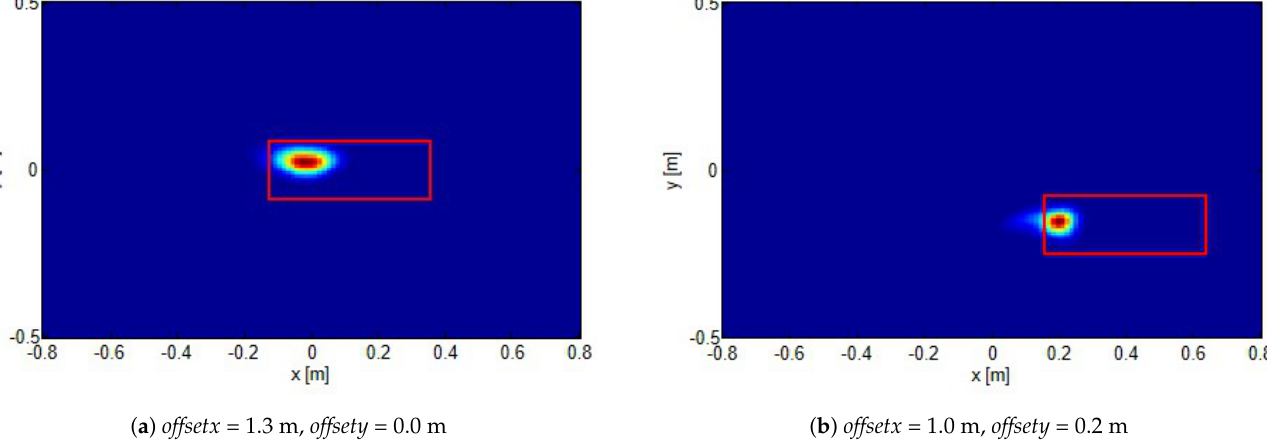
Figure 6. The same as in Figure 5 but incident field polarized orthogonal with respect to the previous